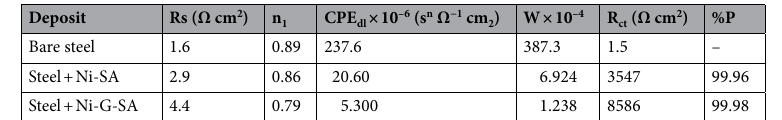
Table 5. The impedance parameters for the bare steel and superhydrophobic coated steel in 0.5 M NaCl solution.